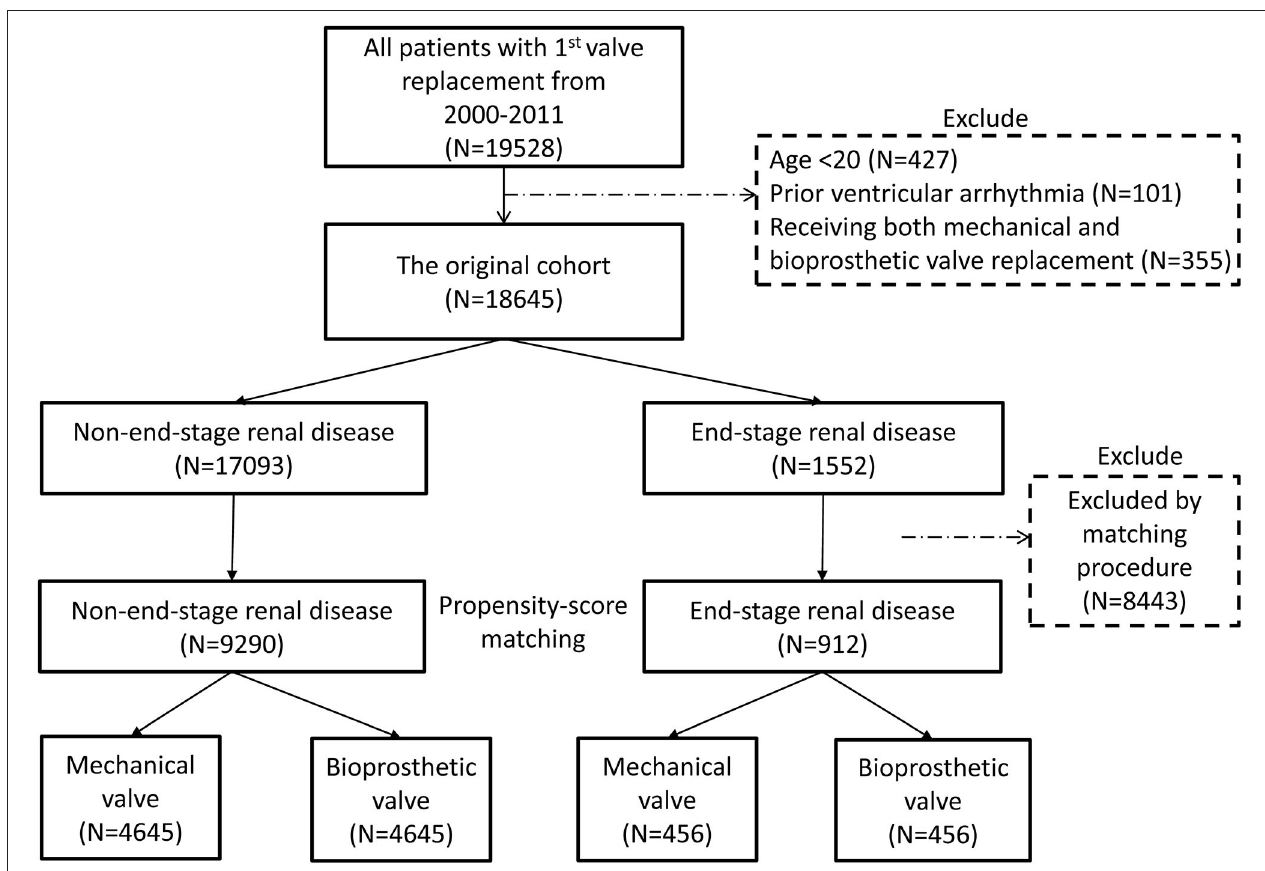
FIGURE 1 | Flow chart of the present study. The process of study population selection and propensity score matching is presented. After PSM, 9,290 and 912 patients were included in the non-ESRD group and ESRD group, respectively. Both groups had equal number of patients who had mechanical and bioprosthetic valve replacement. ESRD, end-stage renal disease; PSM, propensity score